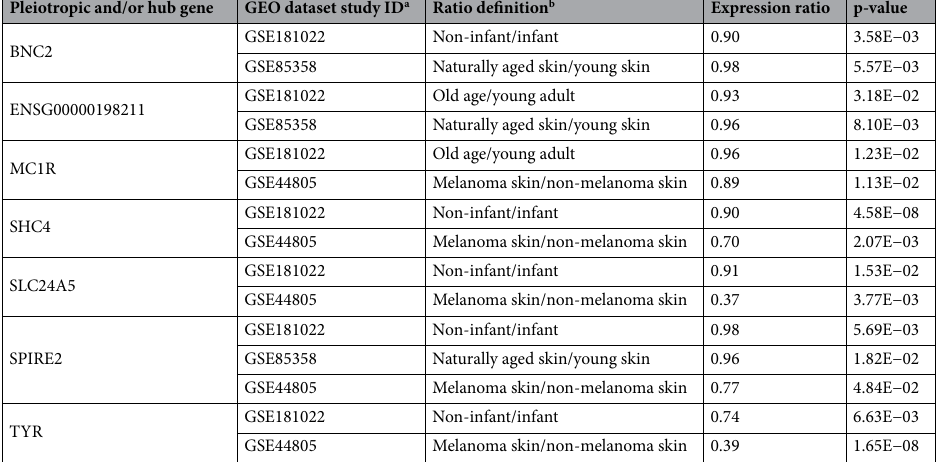
Table 3. Differentially expressed pleiotropic and hub genes associated with chronological age. a GSE181022 controls for Sun exposure by using only sun-protected skin. The skin tissue in GSE85358 is skin aged normally, which will typically be exposed concurrently to numerous factors (e.g., chronological age and sun exposure). b The expression ratio is the average expression level in the aged tissue or tissue with skin ageing phenotypes (i.e., cases) divided by (/) the average expression level in the young tissue or tissue without skin ageing phenotypes (i.e., reference). Ratios above 1 indicate higher expression levels in the cases group while ratios below 1 indicate lower expression levels in the cases